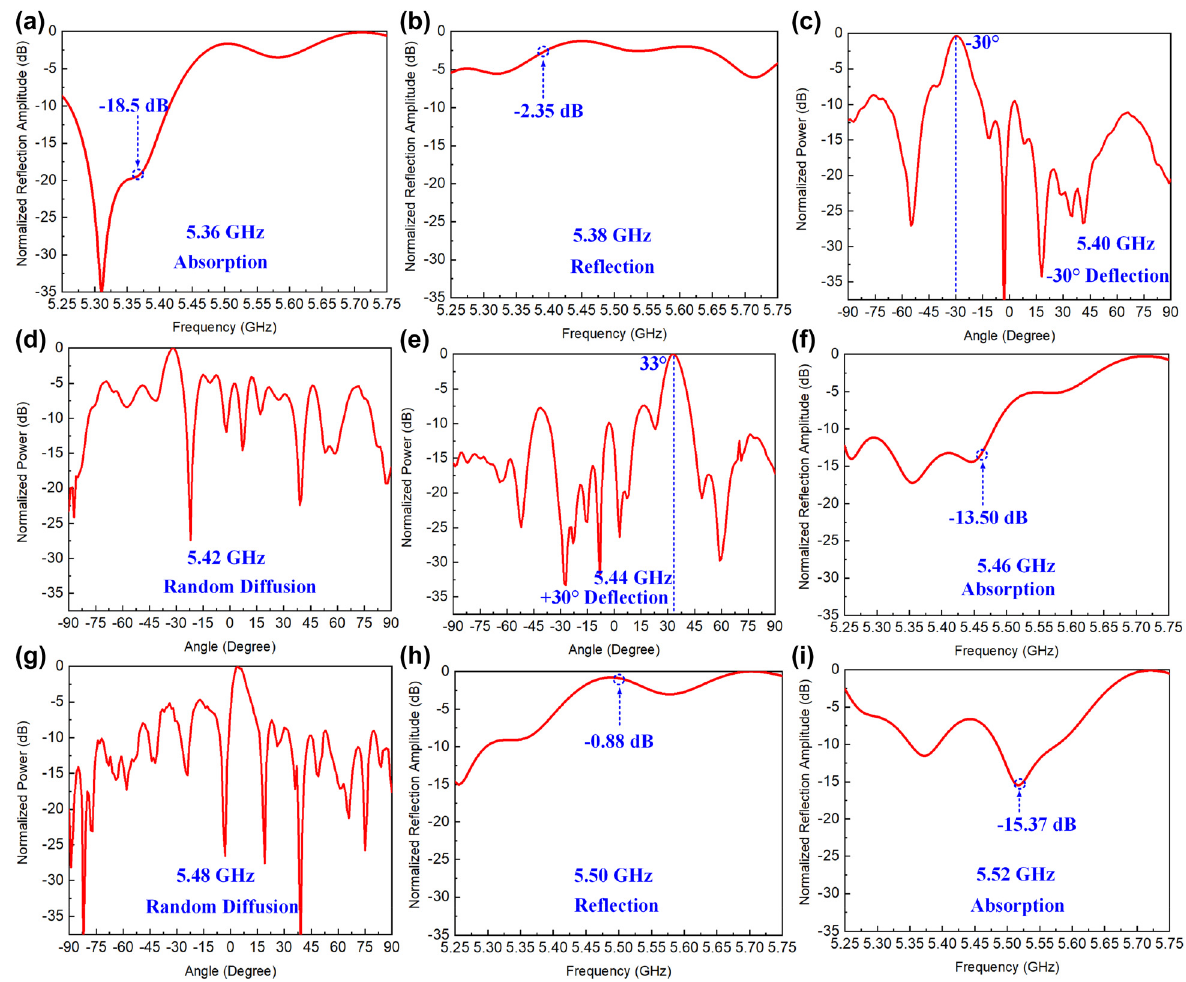
Figure 7: Experimental results. (a) – (i) Measured self-defined EM functions (normalized scattering patterns or reflection spectrum) at different frequencies from 5.36 GHz to 5.52 GHz,